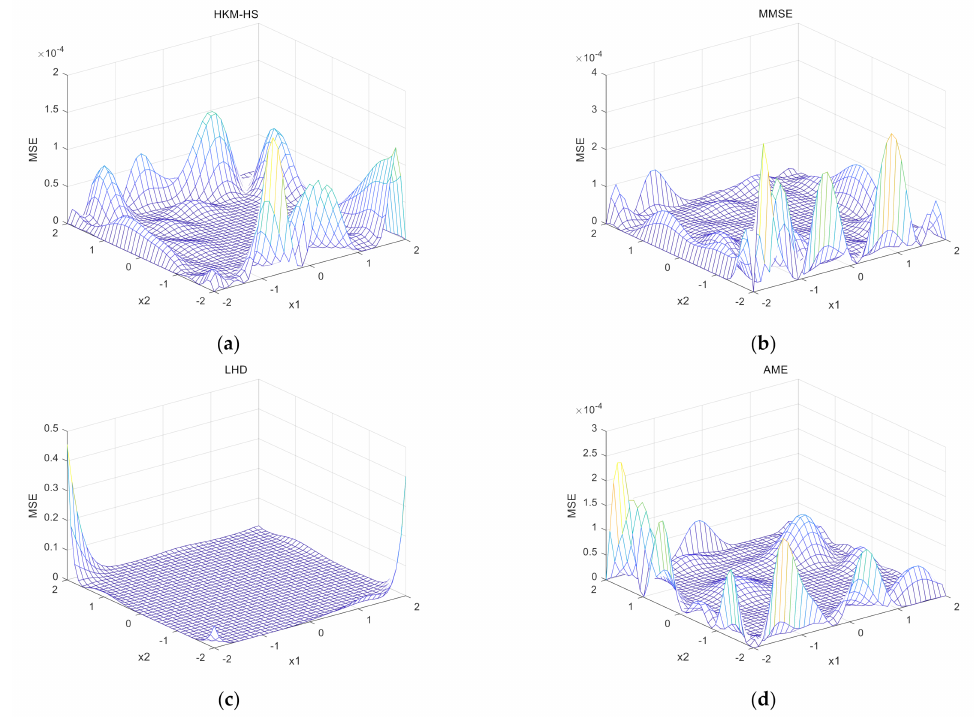
Figure 7. ( a )Test result of sixHump function by HKM-HS; ( b ) Test result of sixHump function by maximum mean square error (MMSE); ( c ) Test result of sixHump function by Latin Hypercube Design (LHD); ( d ) Test result of sixHump function by adaptive maximum entropy